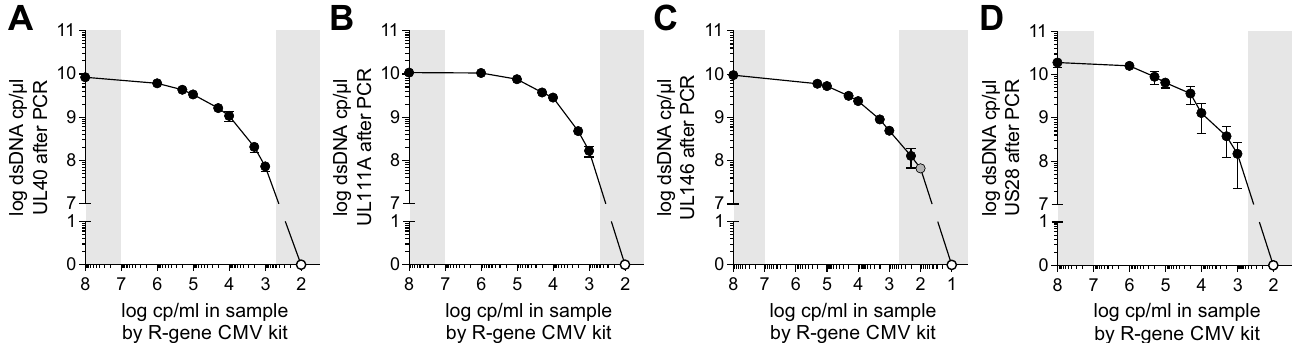
Fig 3. Amplicon yield of specific PCRs on diluted amniotic fluid samples with varying CMV concentrations. Successful amplifications are marked with black dots ( ● ) and unsuccessful amplifications with white dots ( � ). Amplification of UL146 at 100 cp/ml was positive in two of three assays and has been marked with a grey dot ( � ). Grey zones mark areas above and below the limit of quantification of the R-gene CMV kit. n =